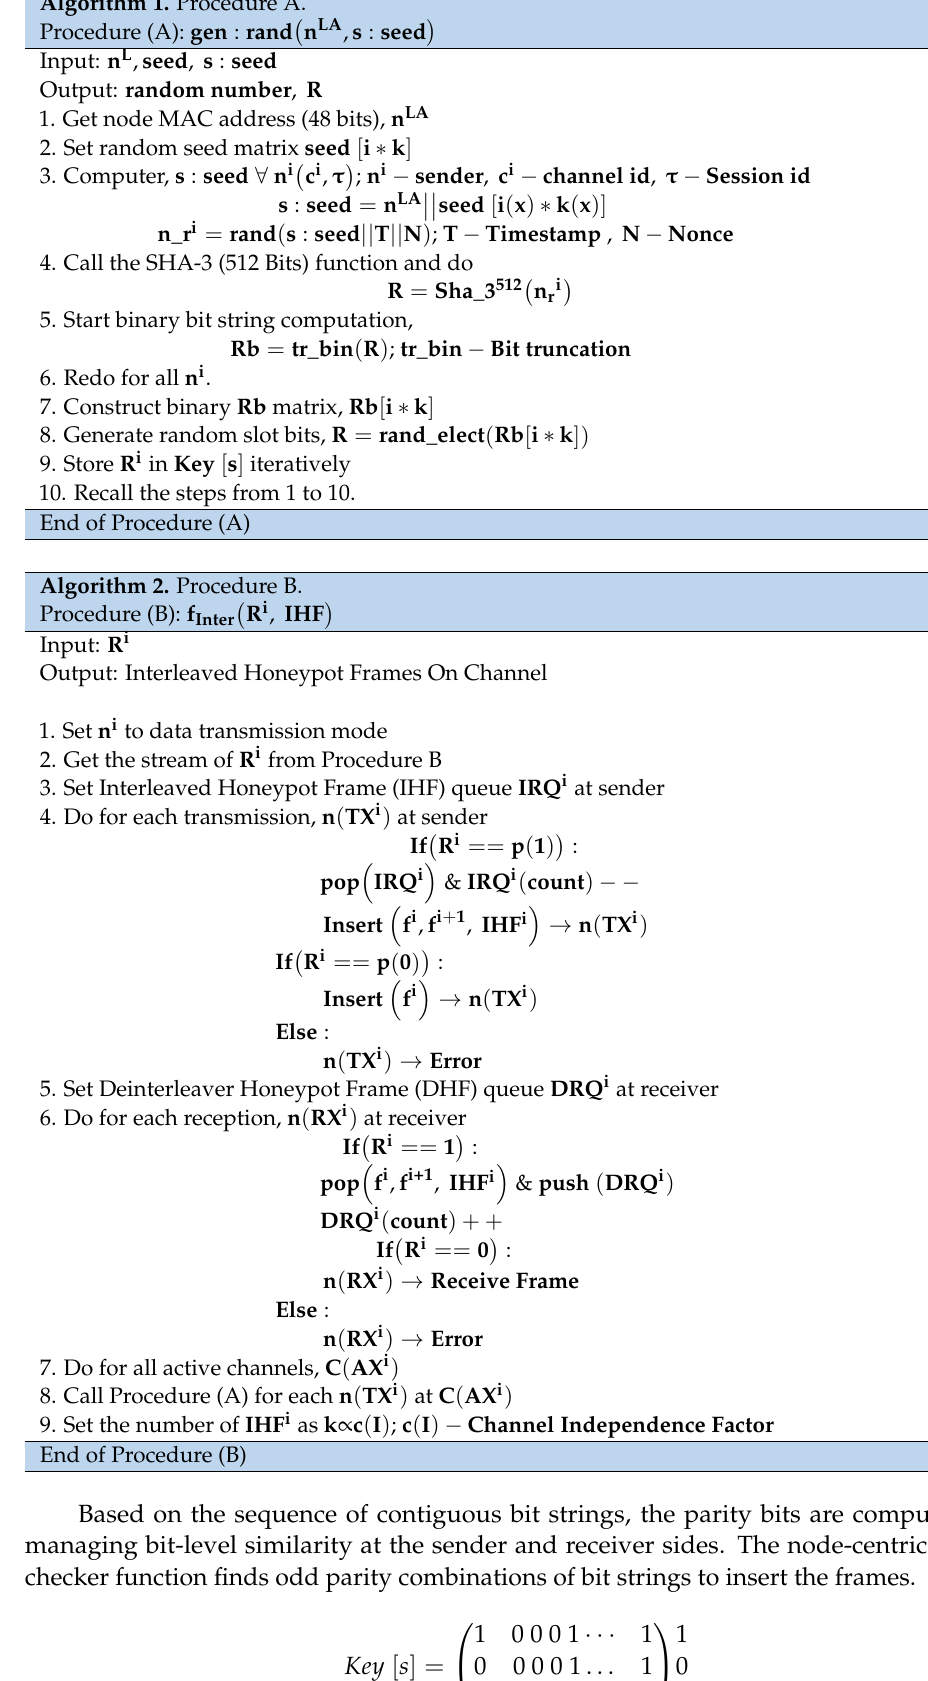
Algorithm 1. Procedure